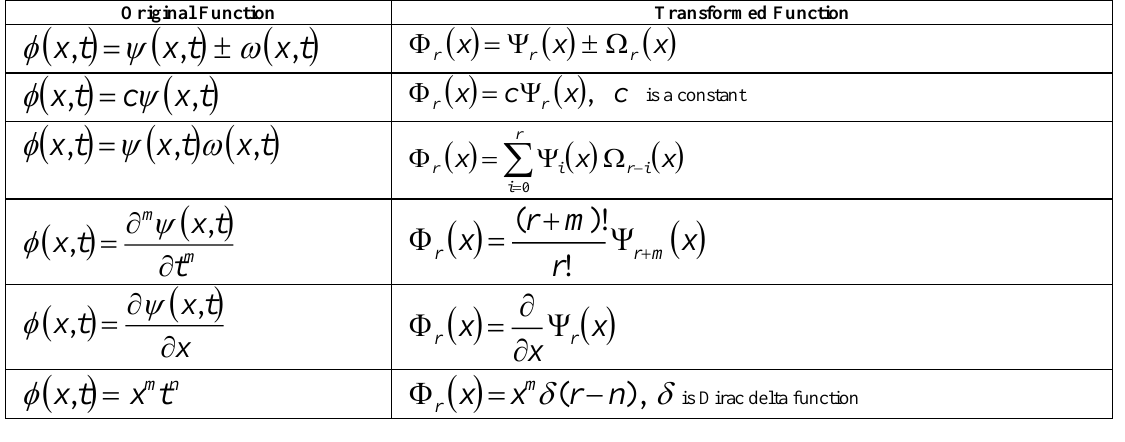
Table 3. Reduced differential transforms